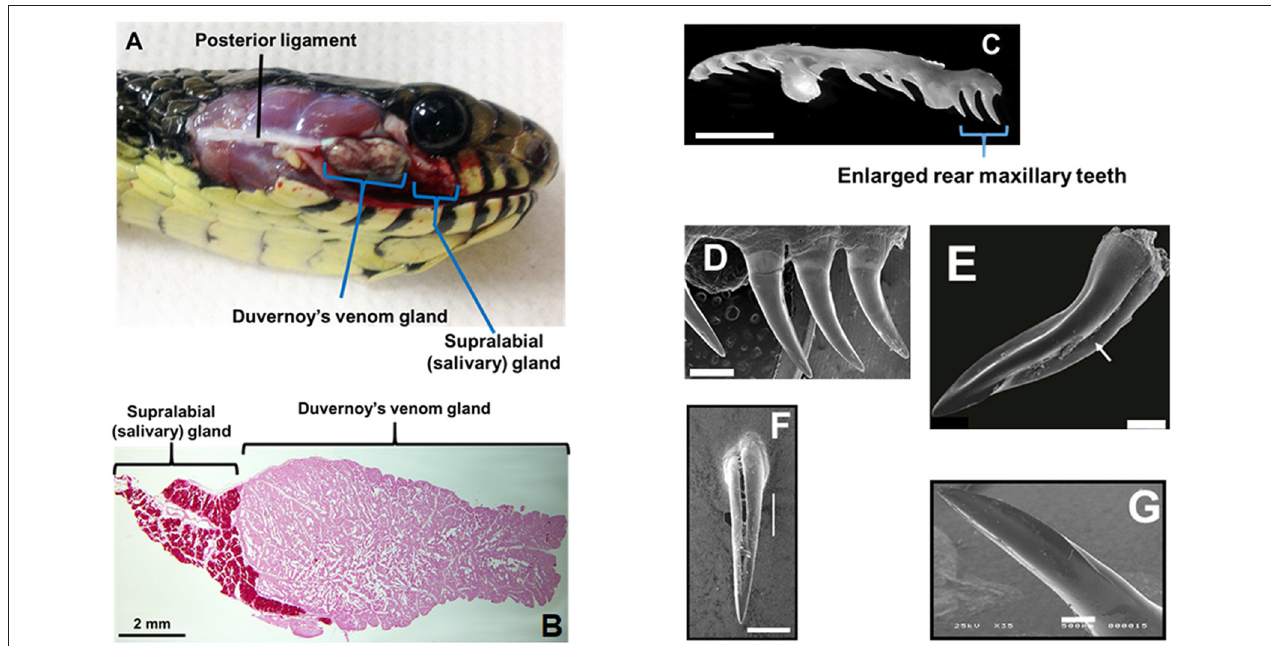
FIGURE 1 | Duvernoy’s venom gland and enlarged maxillary teeth of rear-fanged snakes. (A) Spilotes sulfureus Duvernoy’s venom gland in situ . Note that no muscles are directly associated with the gland—venom secretion is realized via compression of the gland between the skin and the contracting jaw adductor muscles. (B) Duvernoy’s venom gland and supralabial gland of S. sulfureus . (C) Left maxilla (ventro-lateral view) of S. sulfureus showing three serially enlarged rear teeth. Bar = 5mm. (D) SEM micrograph of enlarged rear teeth of S. sulfureus . Bar = 1mm. (E) SEM micrograph of the enlarged rear maxillary fang of Erythrolamprus aesculapii . Note deep anterior groove (arrow) and both anterior and posterior blades. Bar = 0.2mm. (F) Rear maxillary tooth of Boiga irregularis (SEM); note deep anterior groove. Bar = 0.5mm. (G) Enlarged rear maxillary tooth of Hydrodynastes gigas showing anterior-facing blade (SEM). Bar = 0.5mm. (A–D) From Modahl et al. (2018b); (E) from Sánchez et al. (2019); (F,G) from Mackessy